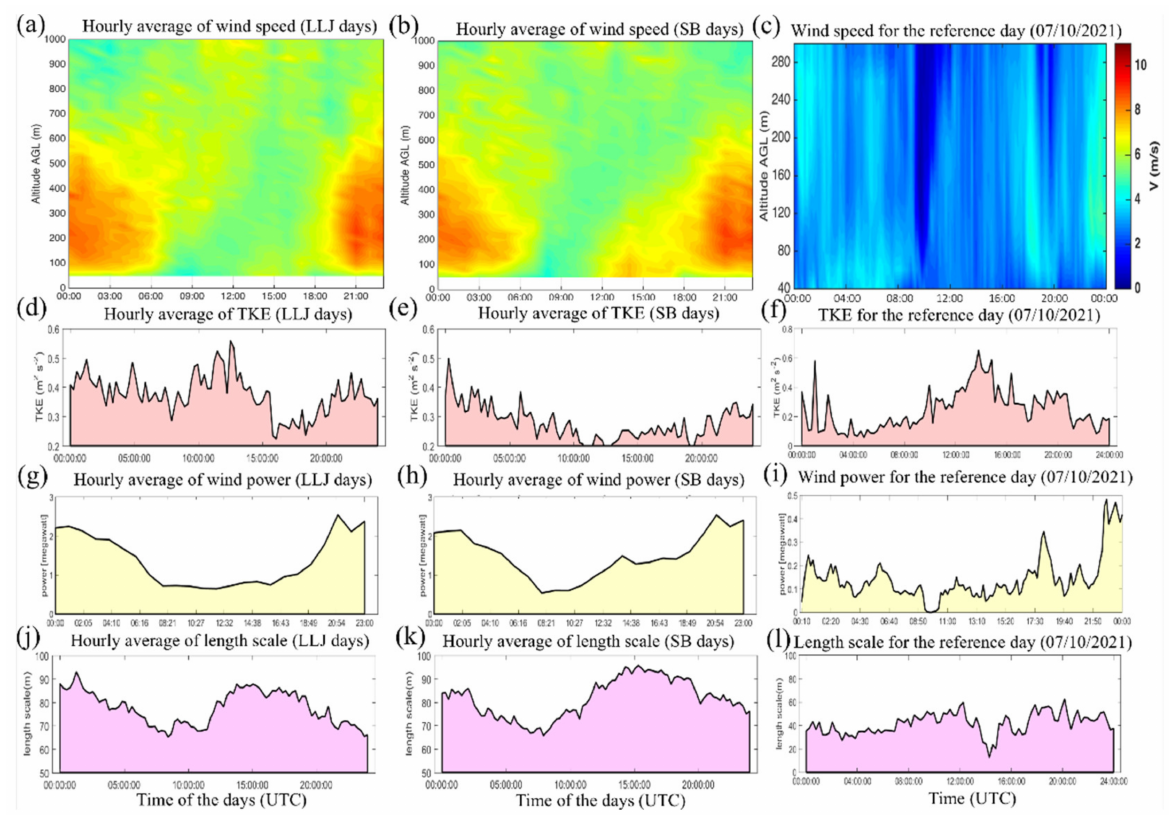
Figure 12. Time height section of hourly average horizontal wind speed using lidar measurements for NLLJ events from WLS100 ( a ); SB events from WLS100 ( b ); and for the reference day from WLS7 ( c ). Time evolution of hourly average TKE at 10 m (AGL) for NLLJ events ( d ); for SB events ( e ); and TKE for the reference day ( f ). Time evolution of hourly average potential power calculated using rotor equivalent wind speed for NLLJ events ( g ); for SB events ( h ); and for the reference day ( i ). Time evolution of hourly average length scale ( L u ) for NLLJ events ( j ); for the SB events ( k ); and for the reference day ( l